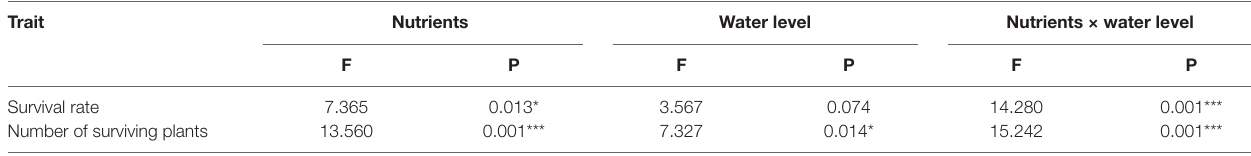
TABLE 2 | Effects of nutrient and water level in winter on survival rate and number of surviving plants of Eichhornia crassipes after winter (two-way ANOVA).